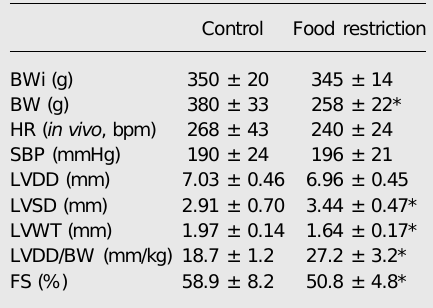
Table 1. General characteristics of rats and echo- cardiographic